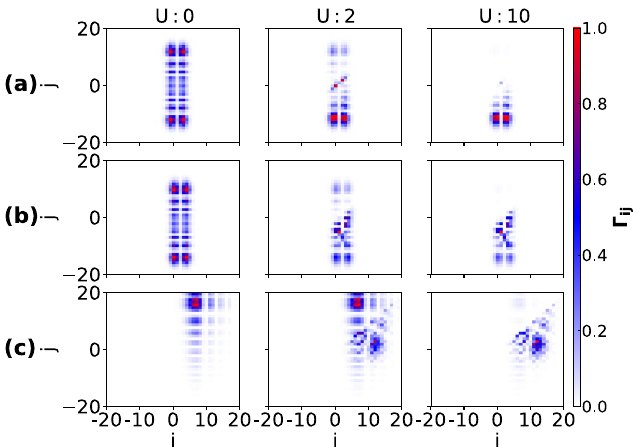
Figure 11. Normalized correlation functions Ŵ ij are plotted corresponding to the parameters considered in Fig. 7 at a particular instant during the time evolution. Ŵ ij in ( a – c ) correspond to the initial states of Eq. (11), (12) and (13) respectively. While Ŵ ij is computed at t = 7 J − 1 for ( a , b ), for ( c ) it is computed at t = 20 J − 1